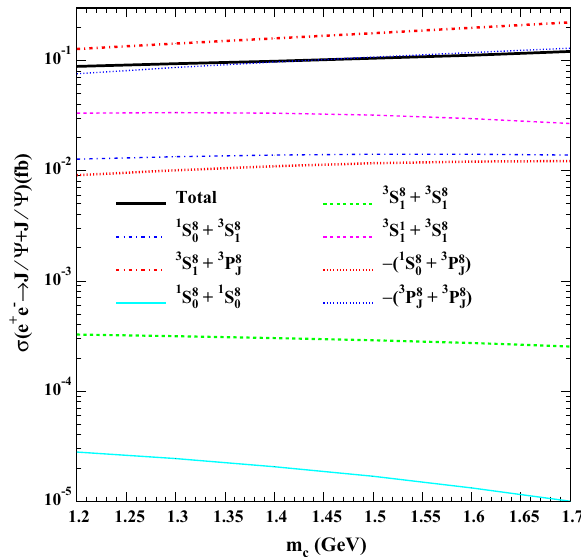
Fig. 2 σ as a function of m c . The renormalization scale is fixed to μ = 3 . 0 GeV r